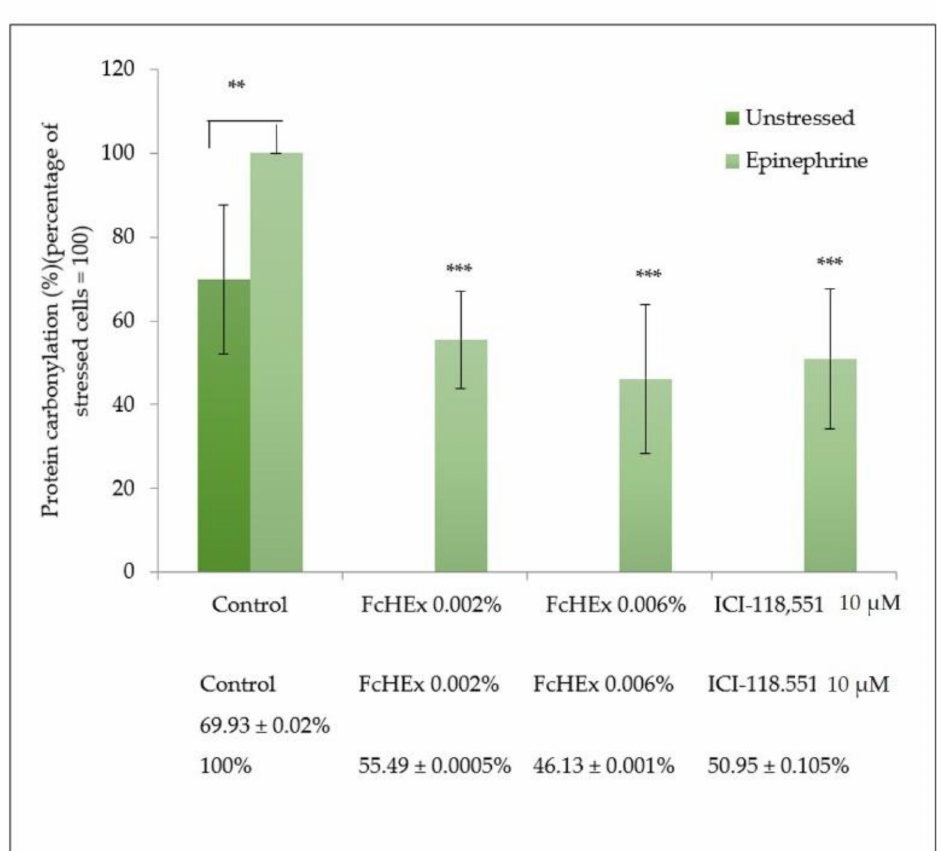
Figure 4. Effect of the FcHEx on the protein carbonylation in the skin keratinocytes. The keratinocytes were treated with the FcHEX or the positive control in the presence of 50 µ M epinephrine for 24 h, fixed with formaldehyde, stained with DNPH (2,4-dinitrophenylhydrazine), and incubated with the specific antibody. The reported values represent the averages of three independent experiments and are expressed as the percentages of cells treated with epinephrine only, which was set to 100%. The asterisks indicate statistically significant values (*** p -value was between 0.0001 and 0.001; ** p -value was between 0.001 and